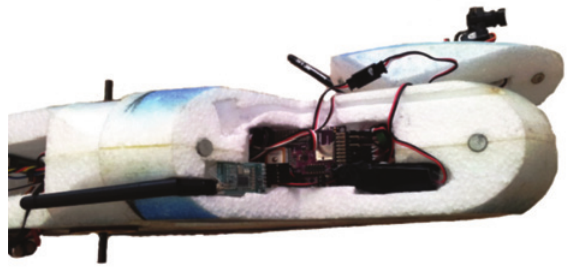
Fig. 2. Ardu Pilot Mega installation in UAV EPP­FPV